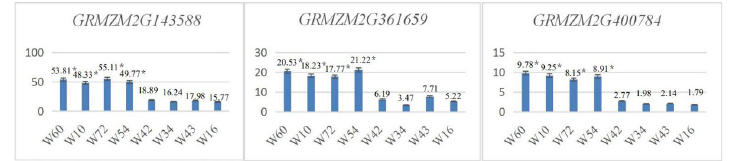
Fig 10. GRMZM2G143588 , GRMZM2G361659 and GRMZM2G400784 qRT-PCR expression levels in the GWAS